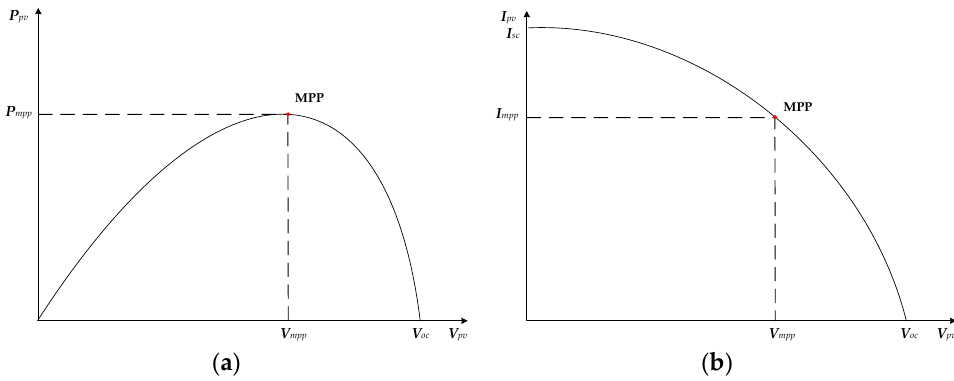
Figure 3. The characteristic curve of PV module. ( a ) Current–voltage characteristic curve; ( b ) power– voltage characteristic curve.